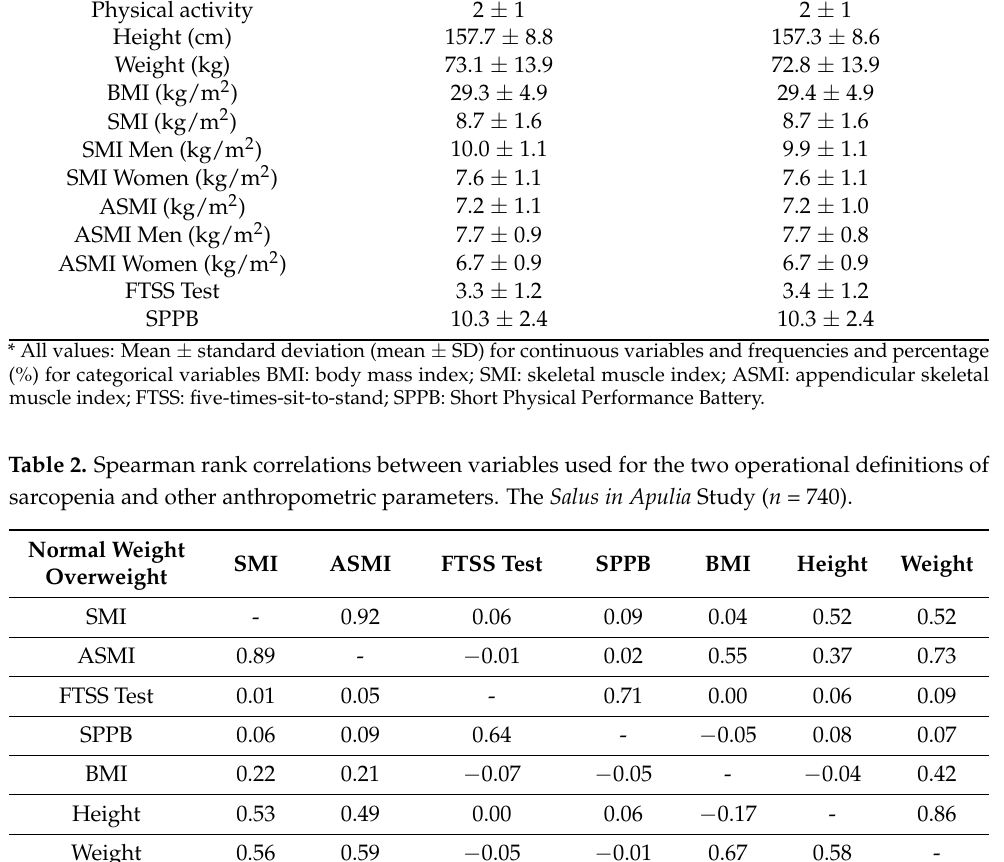
Table 1. Sociodemographic and lifestyle-related characteristics of study participants. The Salus in Apulia Study ( n = 740). Variables * Age (years) 74.9 ± 6.0 75.5 ± 5.9 Smoking (Yes) (%) Education (yrs) Physical activity